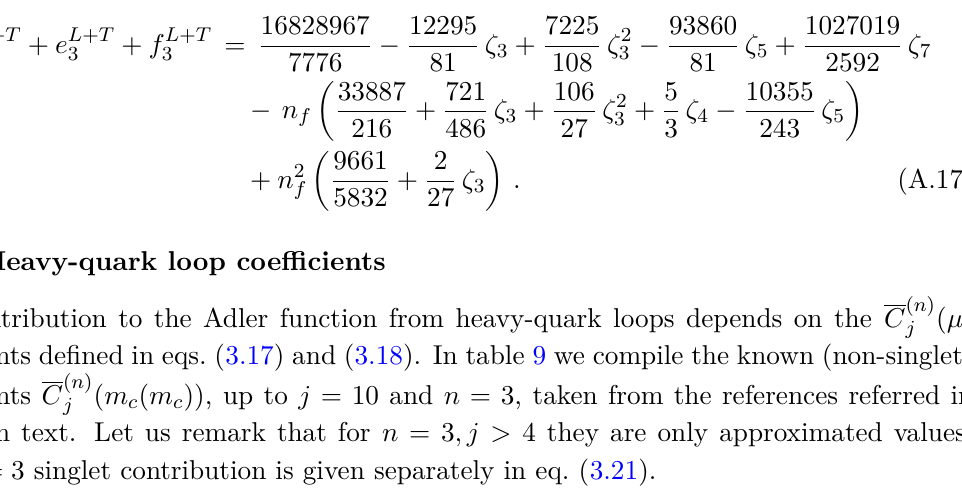
Table 9 . Non-singlet heavy-quark coefficients C ( n ) are only approximate